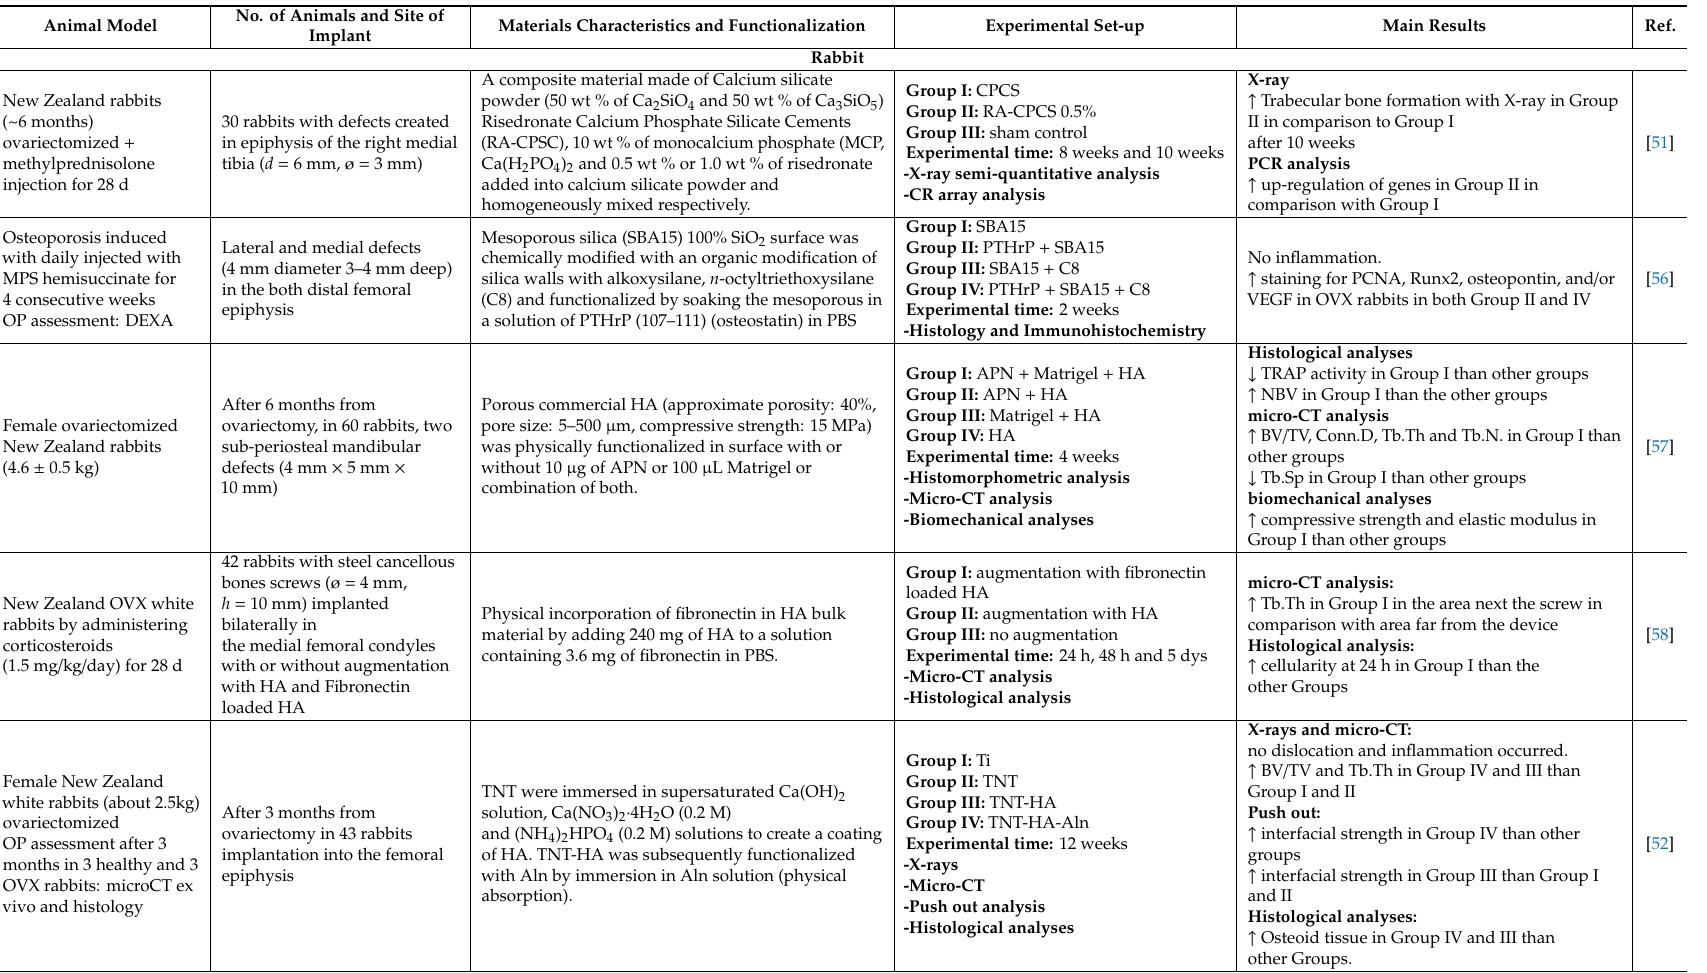
Table A2. Data extraction from medium and large animal models (rabbit and sheep)